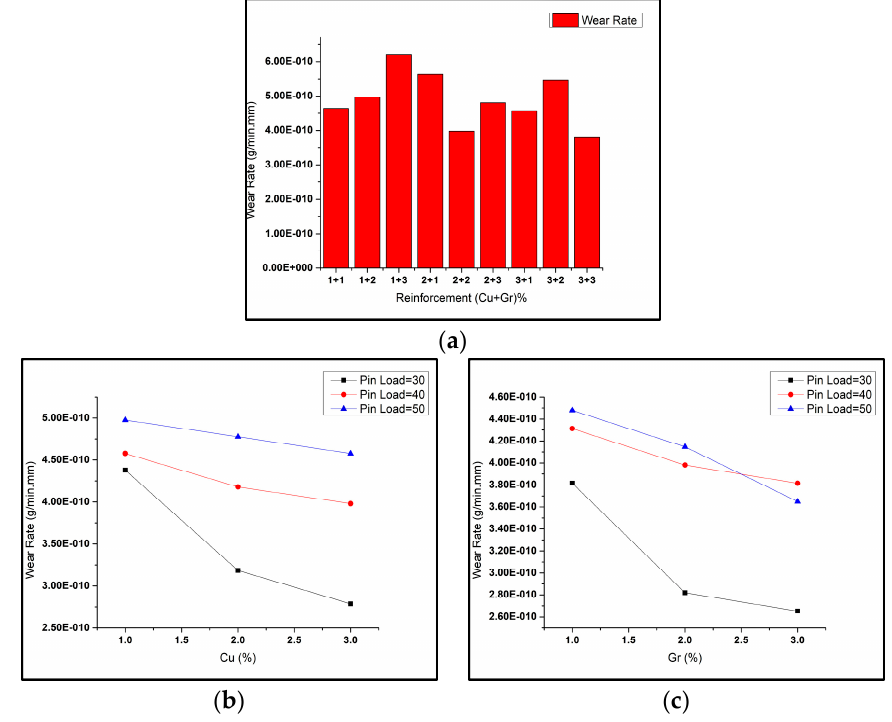
Figure 4. ( a ) Wear rates of composites with varying reinforcement weight% (copper and graphene); ( b ) WR vs. copper weight% at 500 rpm; ( c ) WR vs. graphene weight% at 600 rpm.